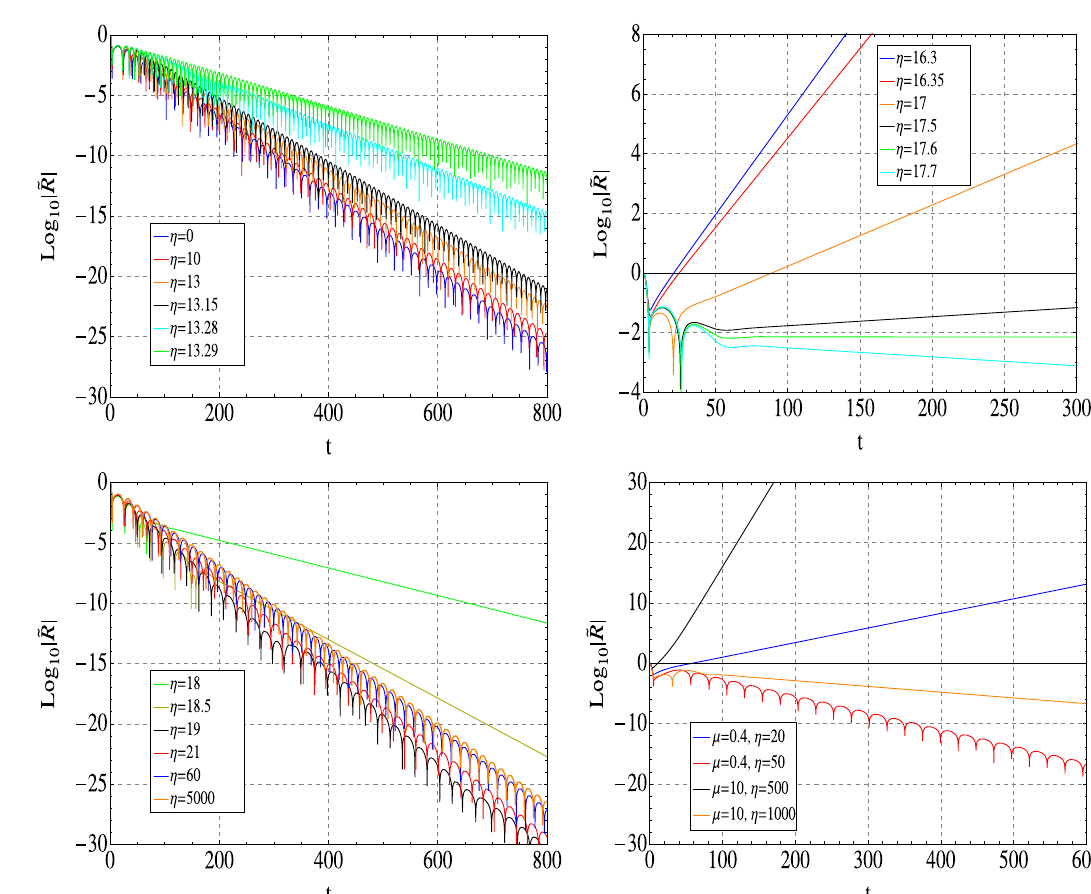
Fig. 5 Field profile with parameters M = (cid:2) = 2 Q = L 2 / 49 = 1 and m 2 = 0. From upper-left to lower-right, we see the emergence of unstable fields in an intermediate region ((iii), (iv)) of the η parameter.